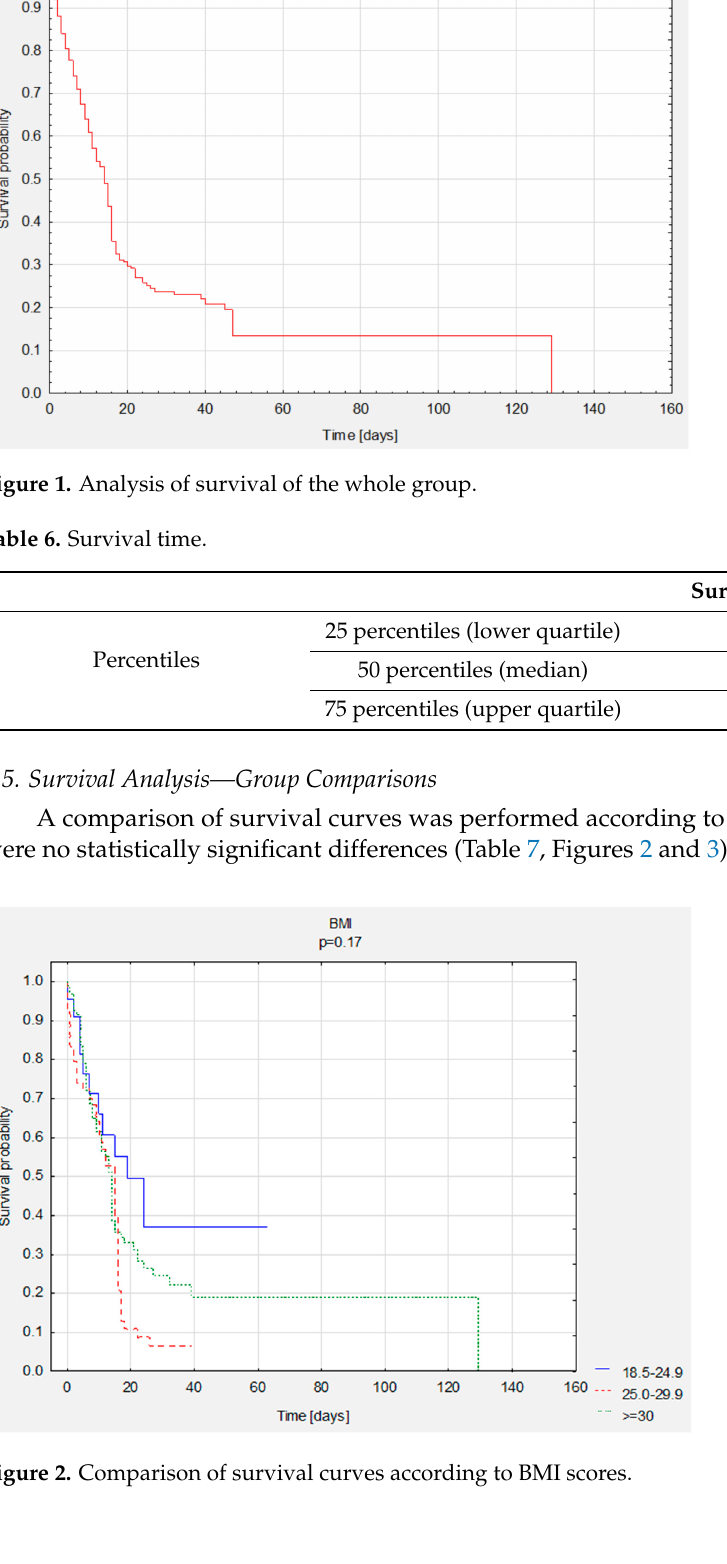
Figure 3. Comparison of survival curves according to NRS scores. Assessment of the influence of selected variables on mortality is shown in Table 8 (Cox proportional hazards regression). It was observed that the risk of death increased in the group with BMI in the range of 25.0–29.9 (HR = 2.18; p = 0.010). Taking the quantitative variables into account, the risk of death was lower in patients with higher levels of TC (HR = 0.996; p = 0.034) and sodium (HR = 0.97; p = 0.033). However, age (HR = 1.03; p < 0.001), NRS (HR = 1.18; p = 0.019), high potassium (HR = 1.34; p = 0.002) and PCT (HR = 1.04; p < 0.001) also affected mortality. Table 8. Assessment of the influence of variables on mortality: the Cox proportional hazards regression model, a single model.